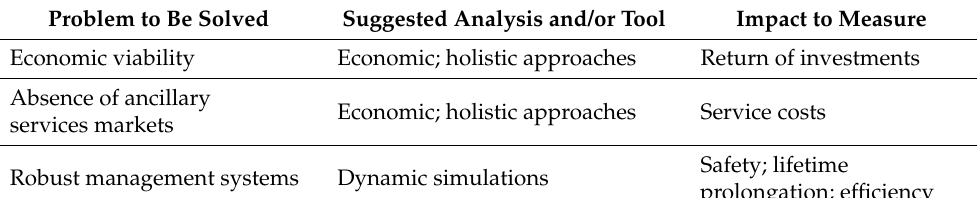
Table 8. Problems, suggestions, and impacts of ESSs. Source: own study.